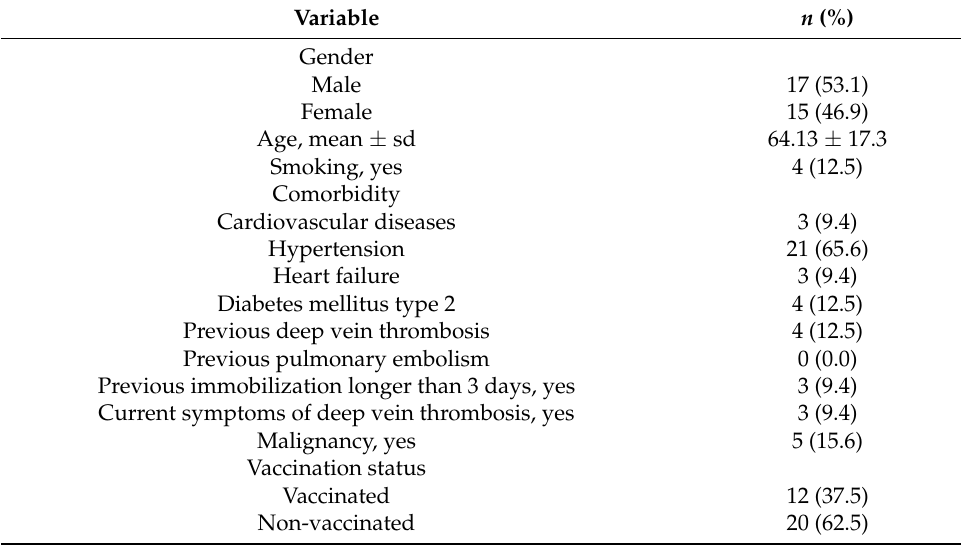
Table 1. Demographic data and comorbidities of the study population.